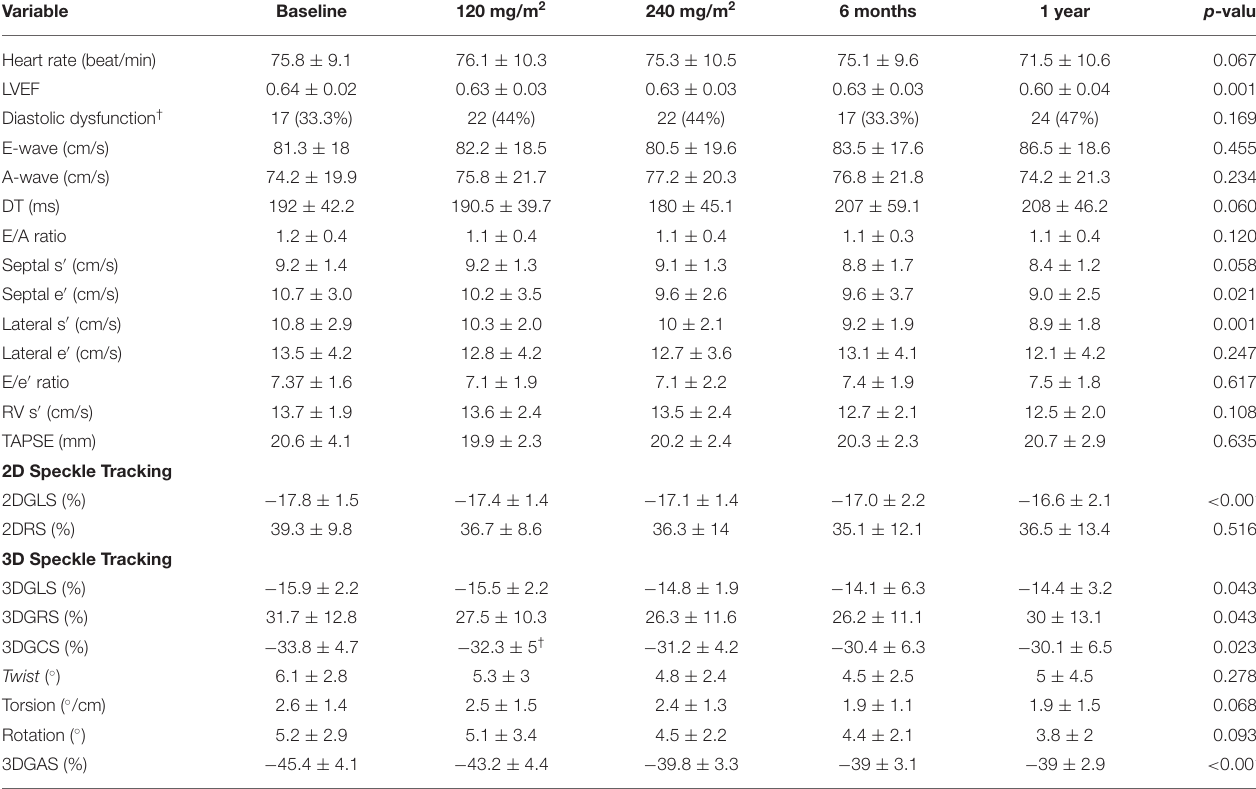
TABLE 3 | Echocardiographic parameters in the 5 evaluation stages.